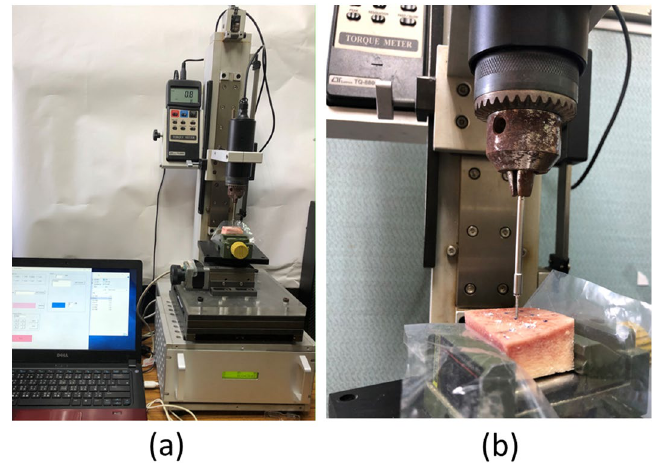
Figure 8. ITV measurement approach of ITV: ( a ) entire view, ( b ) close